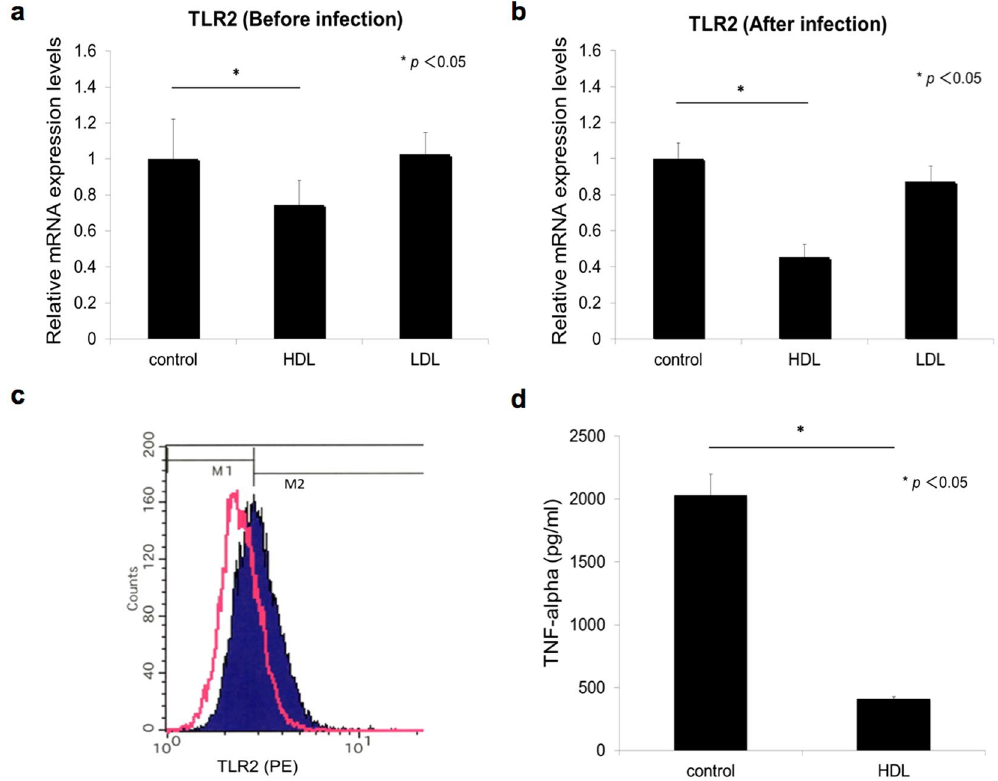
Figure 3. HDL suppresses TLR2 expression of THP1 macrophages. ( a ) Macrophages were cultured with or without adding HDL or LDL (50 µ g/ml) for 6 hours. The TLR2 mRNA expression levels were then quantified using real-time PCR (n = 3) and normalized to GAPDH expression. ( b ) Macrophages were cultured with or without adding HDL or LDL (50 µ g/ml) for 24 hours and then infected with BCG (multiplicity of infection = 10) for 6 hours. The TLR2 mRNA expression level was quantified by real-time PCR (n = 3). ANOVA was used to test for the differences of in means. These assays were repeated twice. ( c ) THP1macrophages were cultured with (merged with pink) or without (filled with purple) addition of HDL (50 µ g/ml) for 6 hours. Surface TLR2 was detected with PE-labeled anti-TLR2 antibody and analyzed by FACScan. The border of M1 and M2 was set at the peak of untreated THP1 cells stained by TLR2 antibody. Calculated % of cells in the M2 area of control cells and HDL-treated cells were 55.8% and 22.4%, respectively. ( d ) THP1 macrophages were cultured with or without addition of HDL (50 µ g/ml) for 24 hours and were then stimulated with the TLR2 ligand Pam3CSK4 (50 ng/ml) for 24 hours. The amounts of TNF- α in the cell culture supernatants (n = 2) were measured by ELISA. ANOVA was used to test for the differences of in means. This assay was repeated